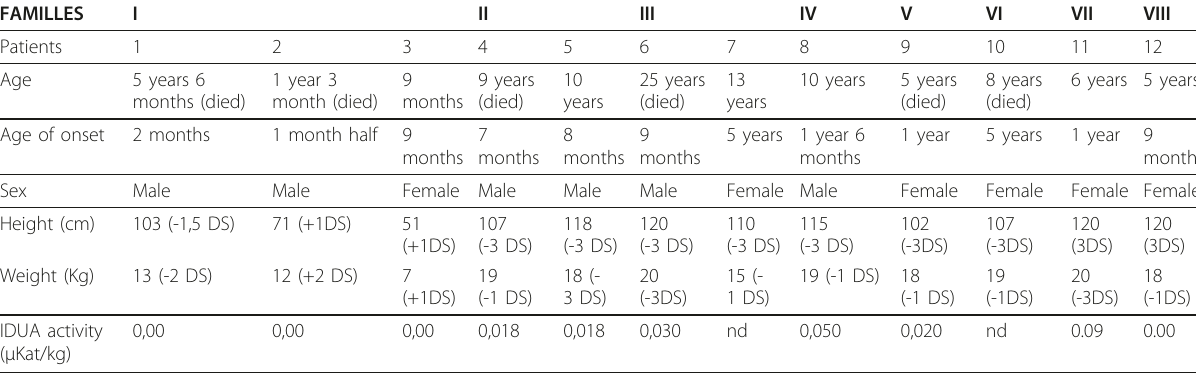
Table 1 Clinical characteristics of Tunisian MPS I patients